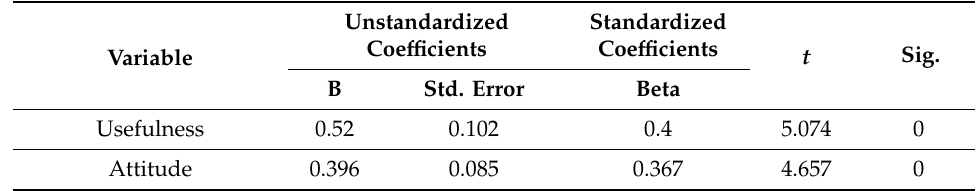
Table A4. Analysis result of usefulness, attitude, and behavioral intention (dependent variable: behavioral intention).